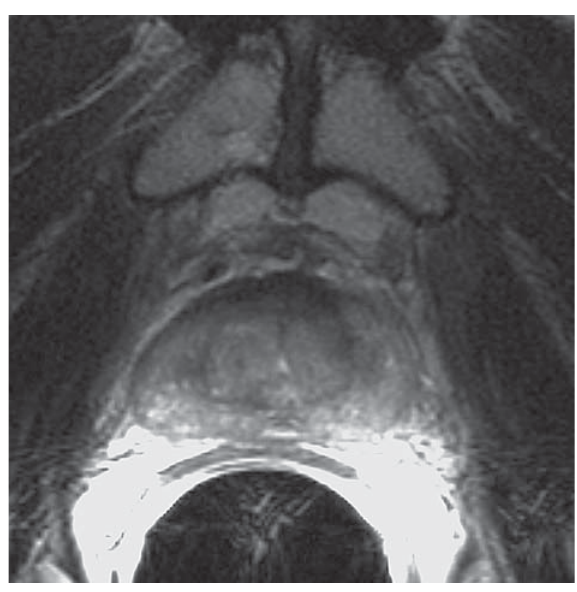
Figure 1 – 61 year-old man with biopsy-proven recurrence of prostate cancer in the left apex and mid-gland 5 years and 6 months after treatment. Axial T2-weighted image (TE/TR 5000/96) shows a focal nodule of low signal intensity in peripheral zone of the left apex of the prostate (asterisk). Both readers interpreted it as a dominant tumoral lesion in left hemi-prostate.